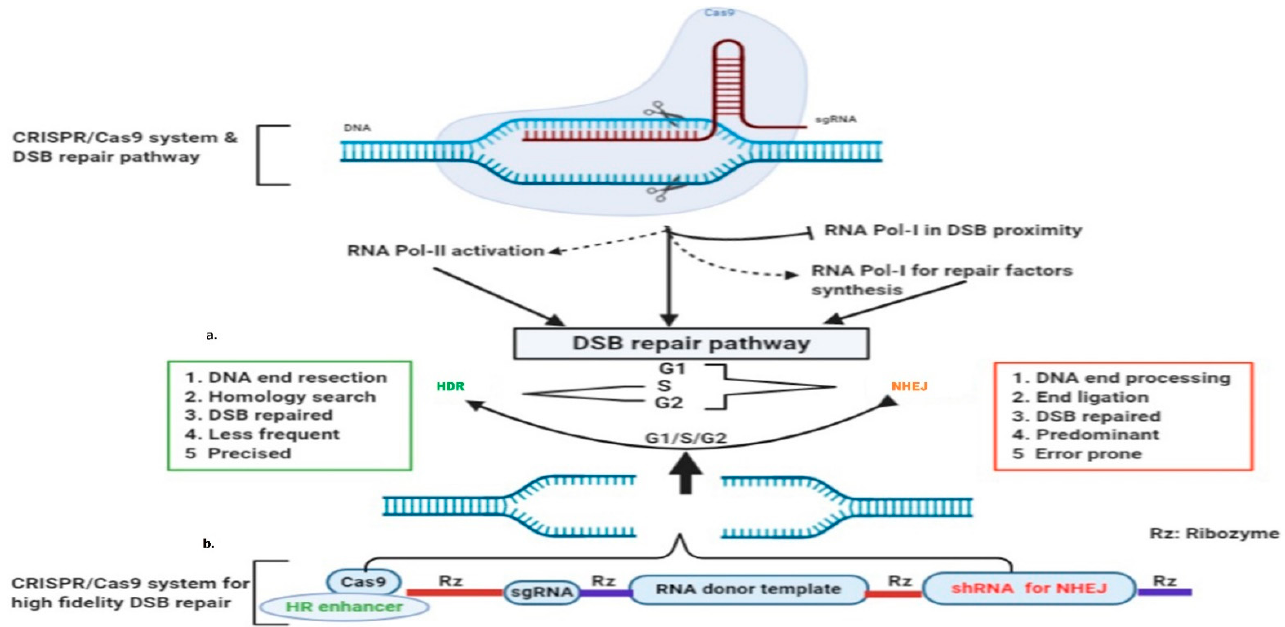
Figure 3. CRISPR-Cas9 induced DSB and RNA-templated high-fidelity repair system: ( a ) Cas9 induced broken ends pause RNA polymerase-I transcription in the DSB vicinity, and activate RNA Polymerase-II and RNA polymerase-I for the synthesis of DSB repair factors; ( b ) single construct for Cas9 expression ribozyme mediated transcription of sgRNA, donor template with desired sequence, and shRNA for NHEJ suppression.